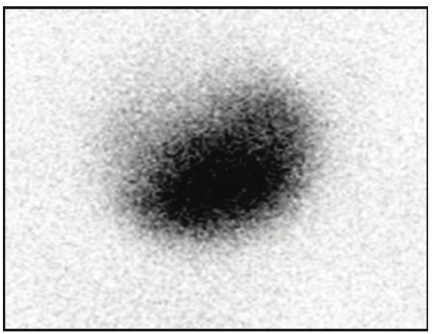
Figure 2: 99 m TC thyroid scan showing exclusive tracer uptake in the left nodule with inhibition of the surrounding